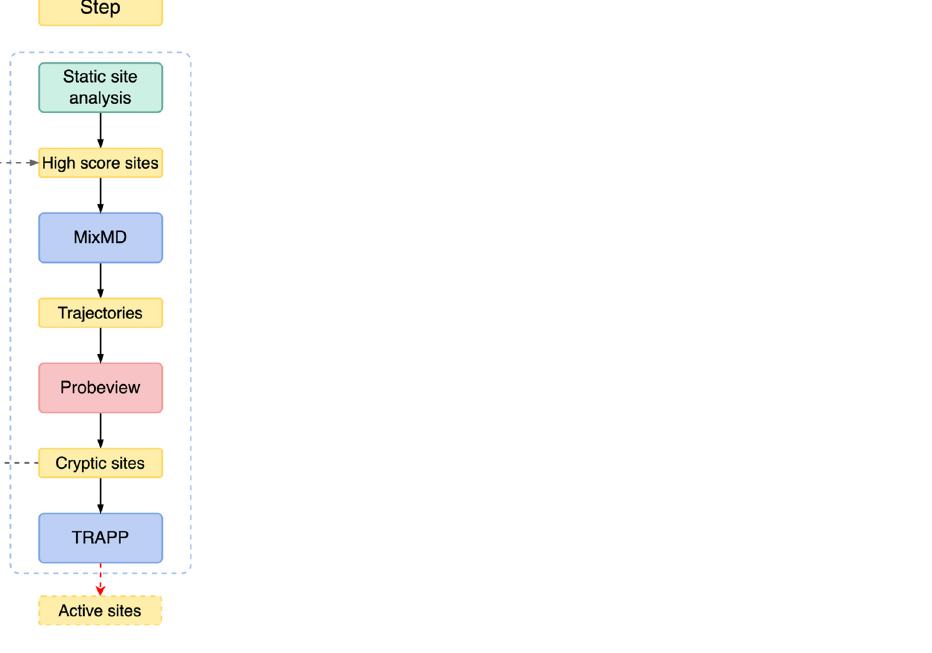
Figure 2. The flow of this research work : (1) Static site detection. (2) Dynamic simulation of mixed solvents. (3) Density sequencing and statistics of probe molecules. (4) TRAPP analysis. Table 1. The related residues of the pocket boundary.